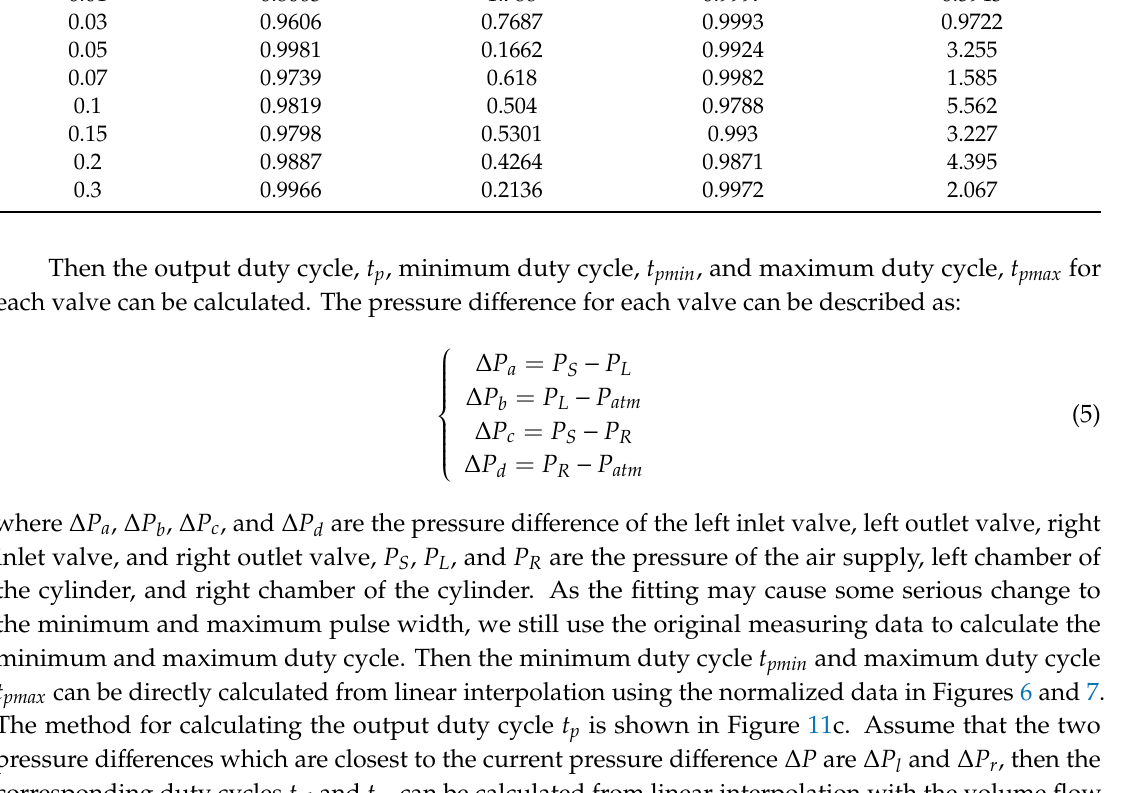
Table 1. Goodness of fitting. root mean square error (RMSE).